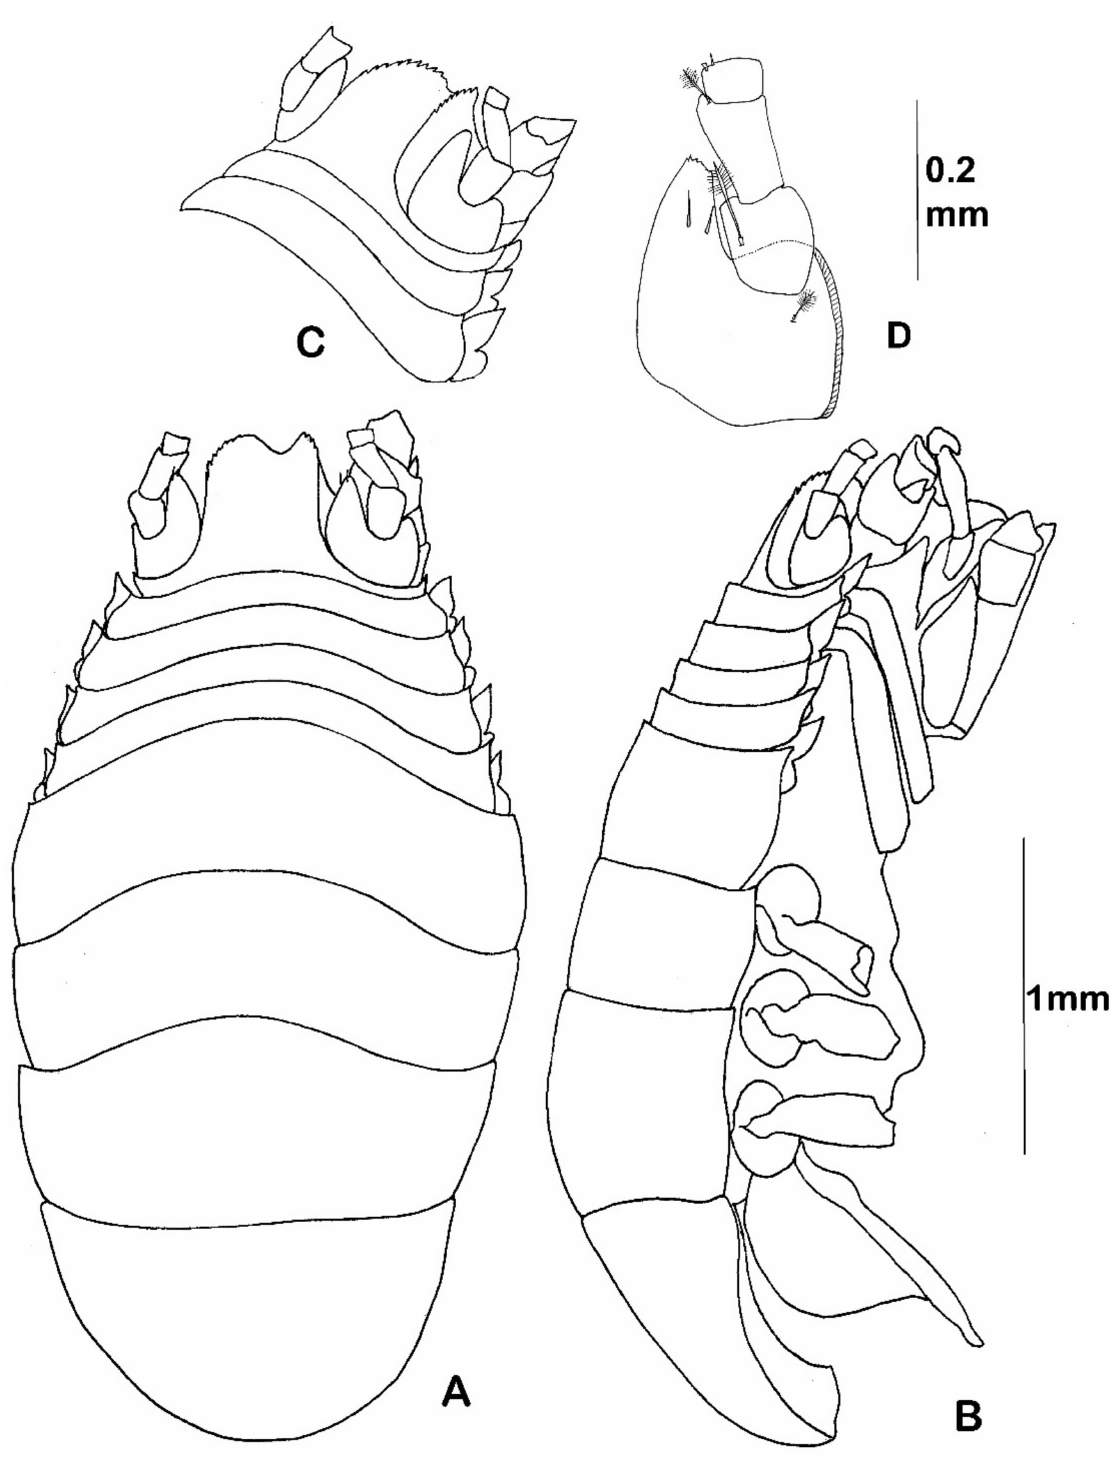
Figure 31. Eurycope jakobi sp. nov. Male holotype (ZMH K-45656): ( A ) dorsal view; ( B ) lateral view; ( C ) anterior body part, oblique view; ( D ) antenna